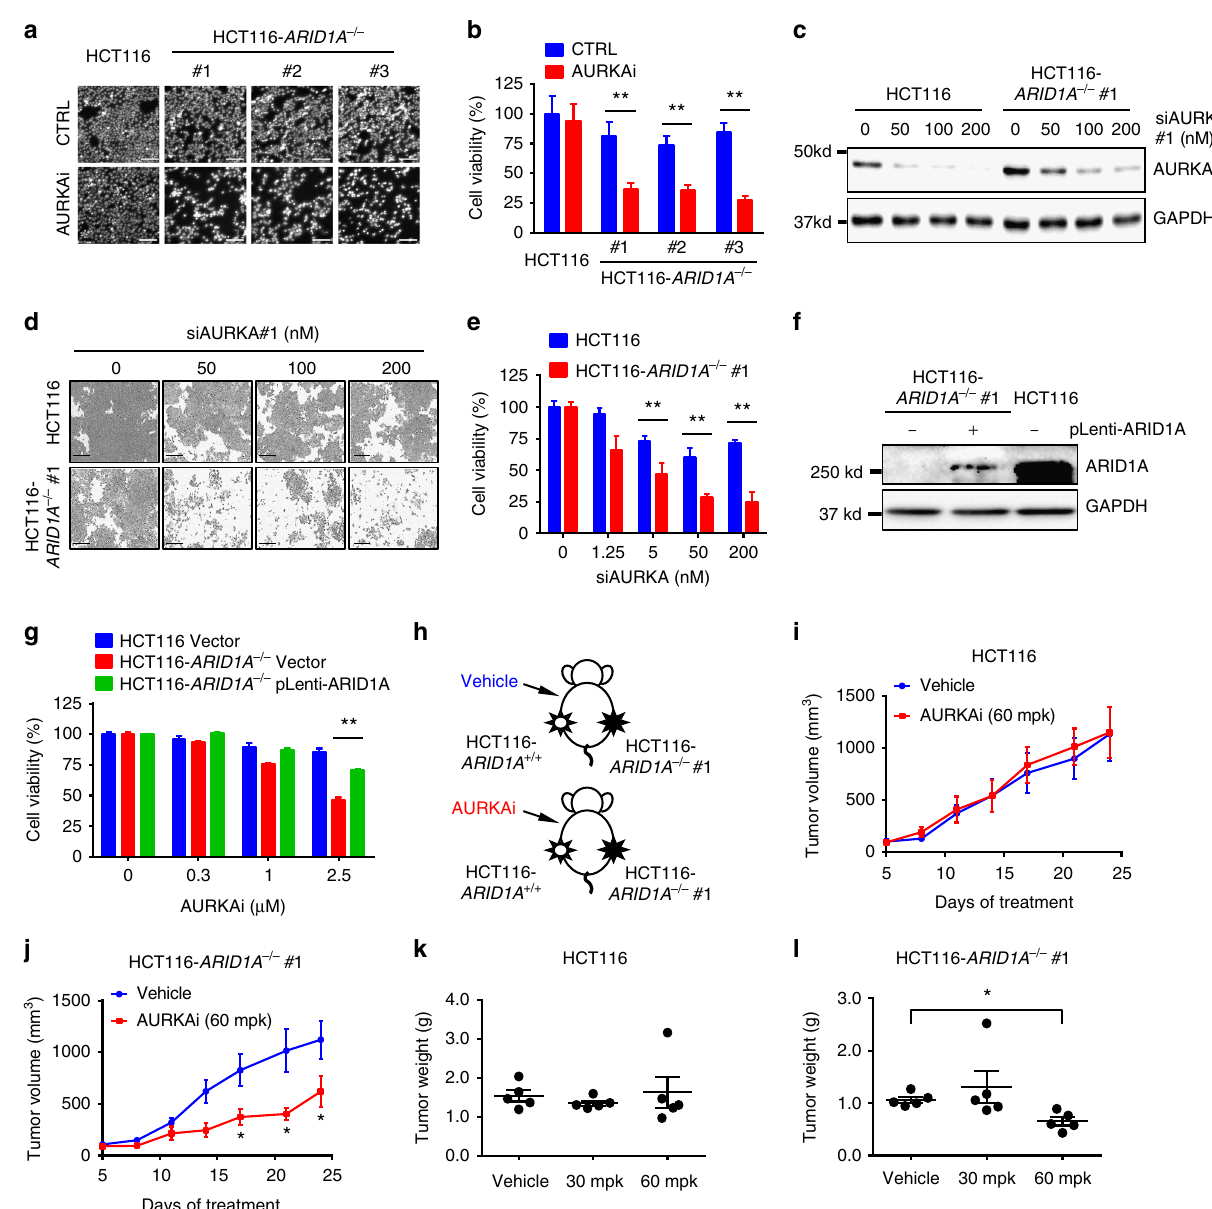
Fig. 2 In vitro and in vivo synthetic lethality in ARID1A-KO HCT116 cells by AURKA inhibition. a Synthetic lethality in ARID1A − / − HCT116 cells by AURKAi. ARID1A + / + HCT116 or three ARID1A − / − clones were treated with 1 μ M AURKAi for 72 h and nuclei were stained with Hoechst 33342. Scale bars, 100 µ m. b Nuclear density was measured with Image J software as a surrogate for cell viability. Error bars represent s.d. ** P < 0.01, Student ’ s t test. c Silencing of AURKA expression in ARID1A isogenic cell pair by siRNA (siAURKA#1). GAPDH was used as a loading control. d Synthetic lethality in ARID1A − / − HCT116 cells by AURKA siRNA. ARID1A + / + or ARID1A − / − clone was transfected with various concentrations of AURKA siRNA for 72 h and the cell images were taken with IncuCyte ZOOM. Scale bars, 300 µ m. e Integrated density was measured with the IncuCyte ZOOM software as a surrogate for cell viability. Error bars represent s.d. ** P < 0.01, Student ’ s t test. f Ectopic overexpression of ARID1A (pLenti-ARID1A) in ARID1A − / − HCT116 cells. g Overexpression of ARID1A reversed the synthetic lethality effect by AURKAi. ARID1A + / + HCT116, ARID1A − / − HCT116, and ARID1A − / − HCT116 transfected with an ARID1A plasmid were treated with AURKAi for 72 h, and the cell viability was assessed with AlamarBlue assay. Error bars represent s.d. ** P < 0.01, Student ’ s t test. h Schematic illustration of mouse tumor xenograft experiments with HCT116 ARID1A isogenic cell pair. i , j Tumor growth curve in nude mice bearing ARID1A + / + HCT116 ( i ) or ARID1A − / − HCT116 ( j ) xenografts after injection of vehicle or 60 mg kg − 1 (mpk) AURKAi. Error bars represent s.d. * P < 0.05 between vehicle and AURKAi treatment groups ( n = 5), Student ’ s t test. k , l Wet weight measurement of the tumors isolated from mice bearing ARID1A + / + HCT116 ( k ) or ARID1A − / − HCT116 ( i ) xenografts at 24 days after injection of vehicle, 30 or 60 mpk AURKAi. Error bars represent s.d. * P < 0.05 between vehicle and 60 mpk AURKAi treatment groups ( n = 5), Student ’ s t